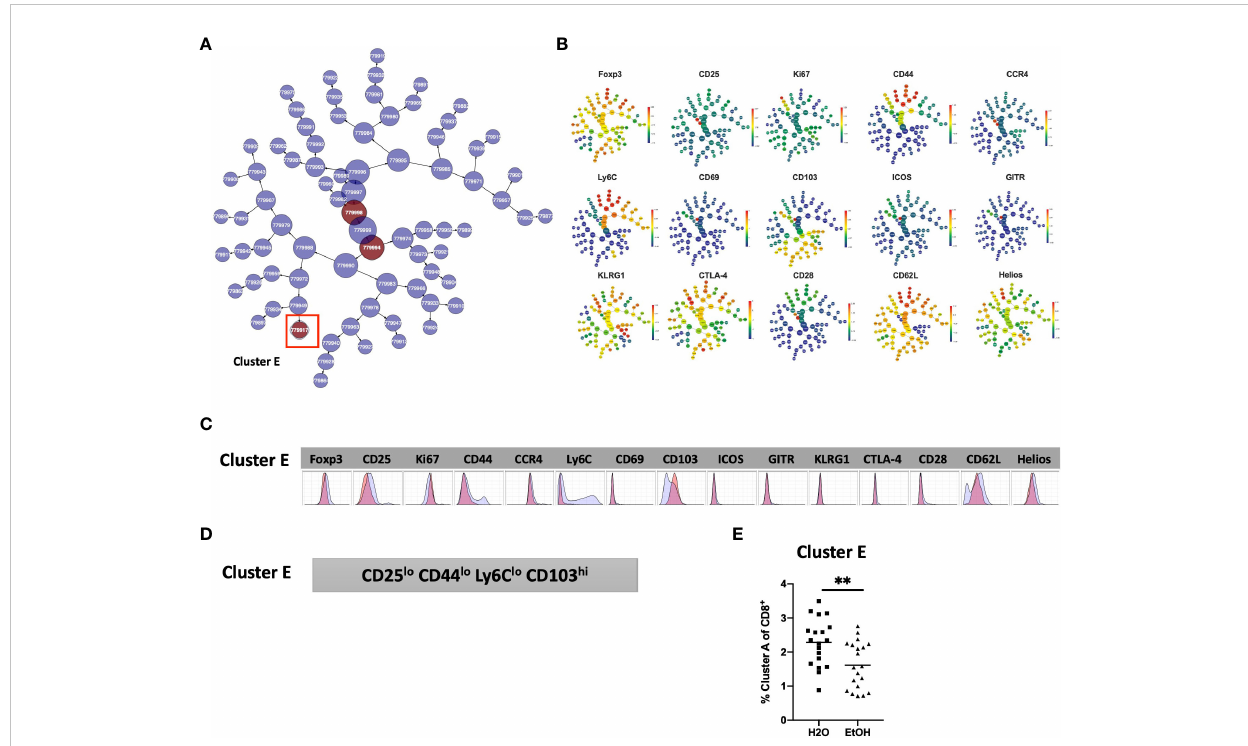
FIGURE 7 Phenotypic analysis of one CD8 + T cell cluster that is signi fi cantly different in alcohol exposed mice. Following CITRUS modeling and identi fi cation of one CD8 + T cell clusters predictive of alcohol drinking mice, phenotypic cluster characterization was performed (A) , assessing marker expression on the viSNE map with the overlaid clusters, (B) CITRUS clusters of interest shown in the feature plots in (A) were compared to expression on corresponding the heatmap marker plots in (B, C) CITRUS marker histogram expression was visualized where blue represents background expression and red represents expression within the cluster of interest. The fi nal phenotypic characterization pro fi le assigned to the cluster of interest is shown in (D) . (E) The frequency of Cluster E (1.6 ± 0.2% vs . 2.3 ± 0.2%, p=0.005) was signi fi cantly decreased in alcohol exposed mice relative to water exposed. Data were tested for normality and compared a t